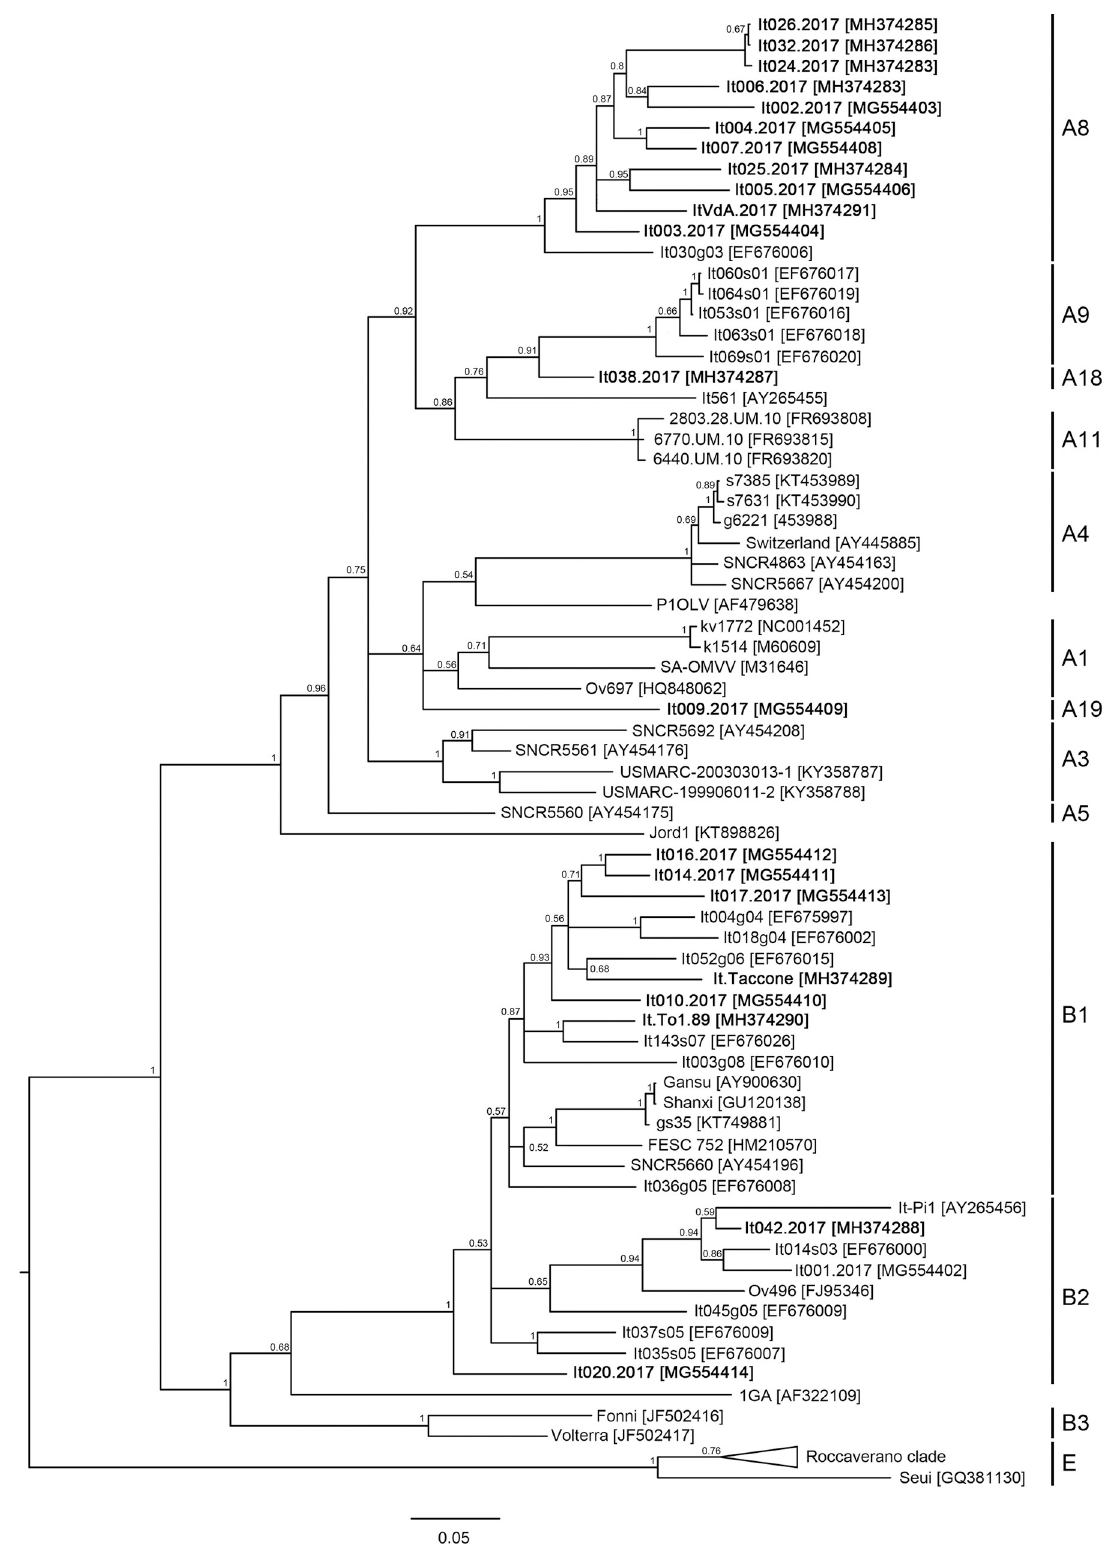
Fig 2. Bayesian tree based on the partial gag sequence alignment. Newly characterized isolates are reported in bold. SRLV subtypes are reported. Posterior probability of each node is showed above branches. https://doi.org/10.1371/journal.pone.0212585.g002 PLOS ONE | https://doi.org/10.1371/journal.pone.0212585 February 21,